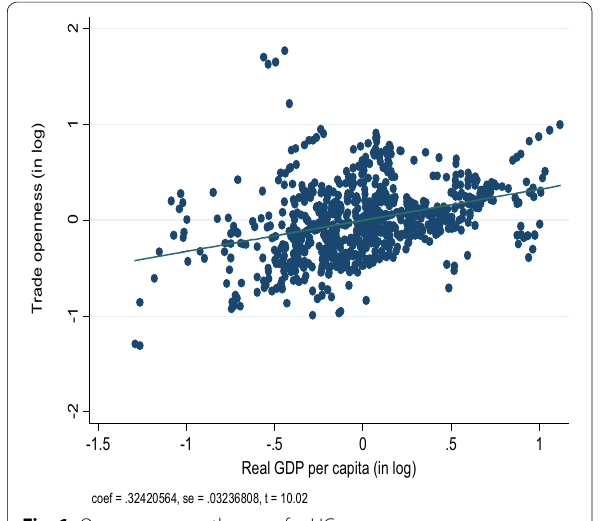
Fig. 1 Openness–growth nexus for LICs